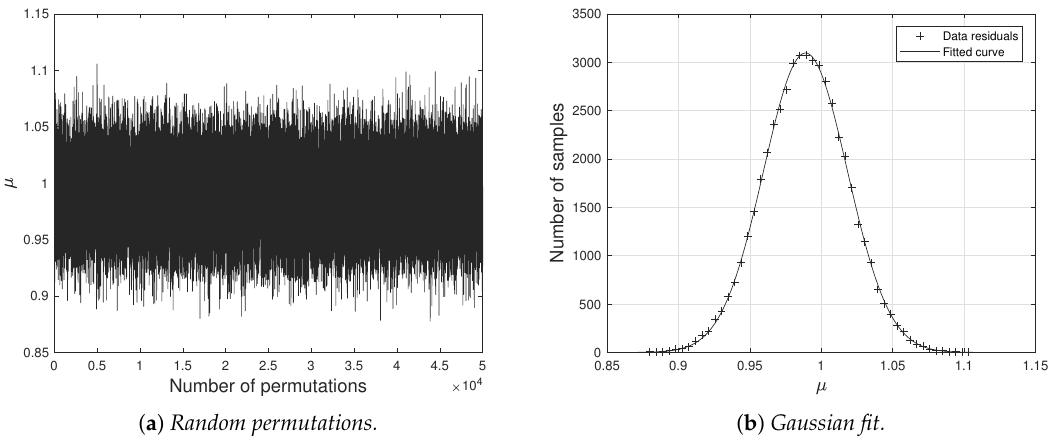
Figure 7. ( a ) Realizations for µ after 50,000 random permutations of the 337 residuals of Figure 3. ( b ) Distribution of the results for the Lense-Thirring parameter µ after the 50,000 permutations. For each realization, µ is obtained by means of the slope of the best linear fit like in Figure 4. The GGM05S model was considered as the background gravitational field of the